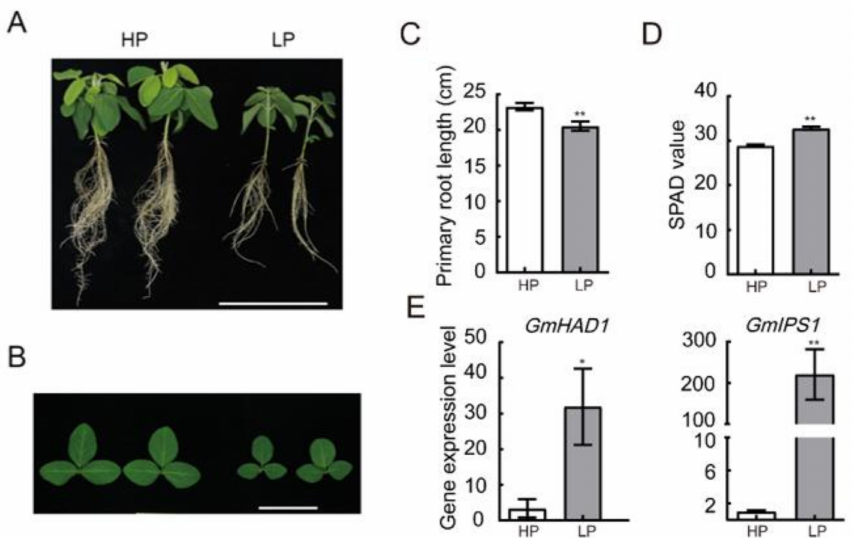
Figure 1. Soybean leaves under phosphate starvation. ( A , B ) Morphology of whole plants ( A ) and the first ternately compound leaves of 18-day-old soybean seedlings under P treatment (HP: 0.5 mM, LP: 0 mM) for two weeks in hydroponics culture. Scale bar = 20 cm in A and 10 cm in B. ( C , D ) Primary root length ( C ) and SPAD value ( D ) of soybean plants under HP and LP treatment, n = 25. ( E ) Expression level of low phosphate responsive genes GmHAD1 and GmlPS1 , n = 3. Error bars: SEM (standard